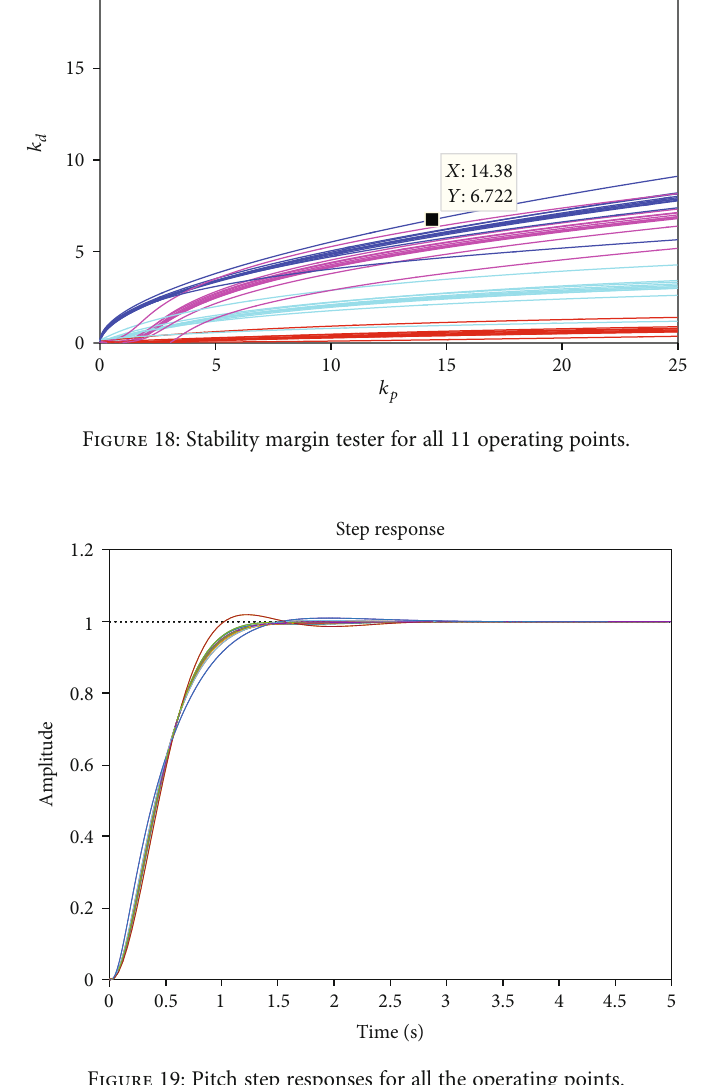
Figure 19: Pitch step responses for all the operating